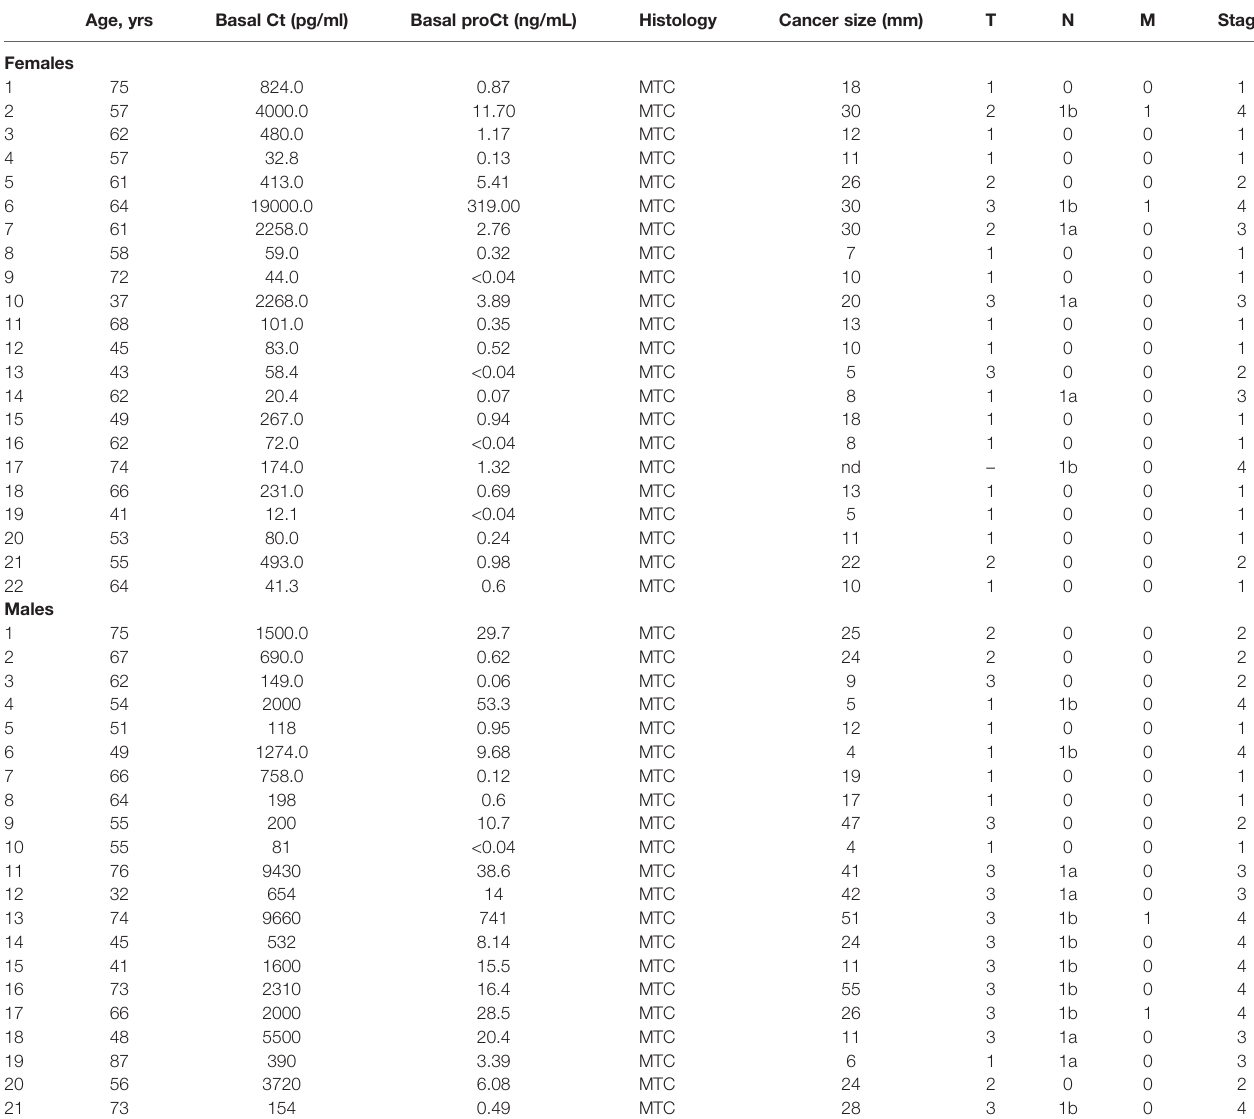
TABLE 1 | Clinical features of the patients retrospectively collected from University of Padua tissue bank submitted to thyroid surgery for medullary thyroid cancer (MTC). Age, yrs Basal Ct (pg/ml) Basal proCt (ng/mL)